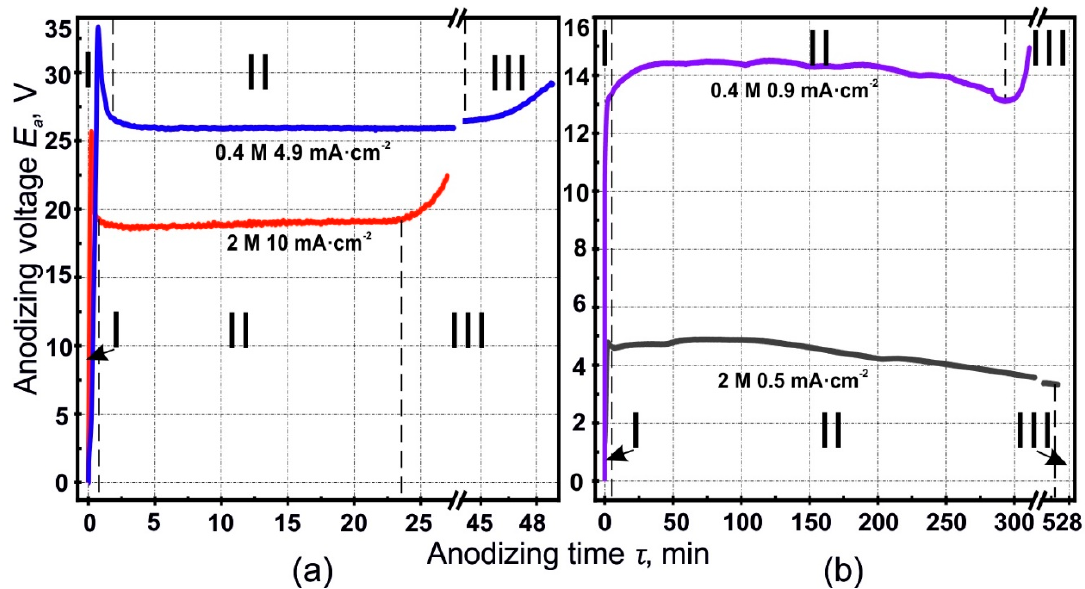
Figure 2. Voltage ‐ time responses of low temperature anodizing aluminum foil at current densities of ( a ) 10, 4.9, and ( b ) 0.9, 0.5 mA ∙ cm − 2 , and sulfuric acid concentrations of 0.4 and 2.0 M. The profiles have been presented in two separate panels, for the sake of clarity.